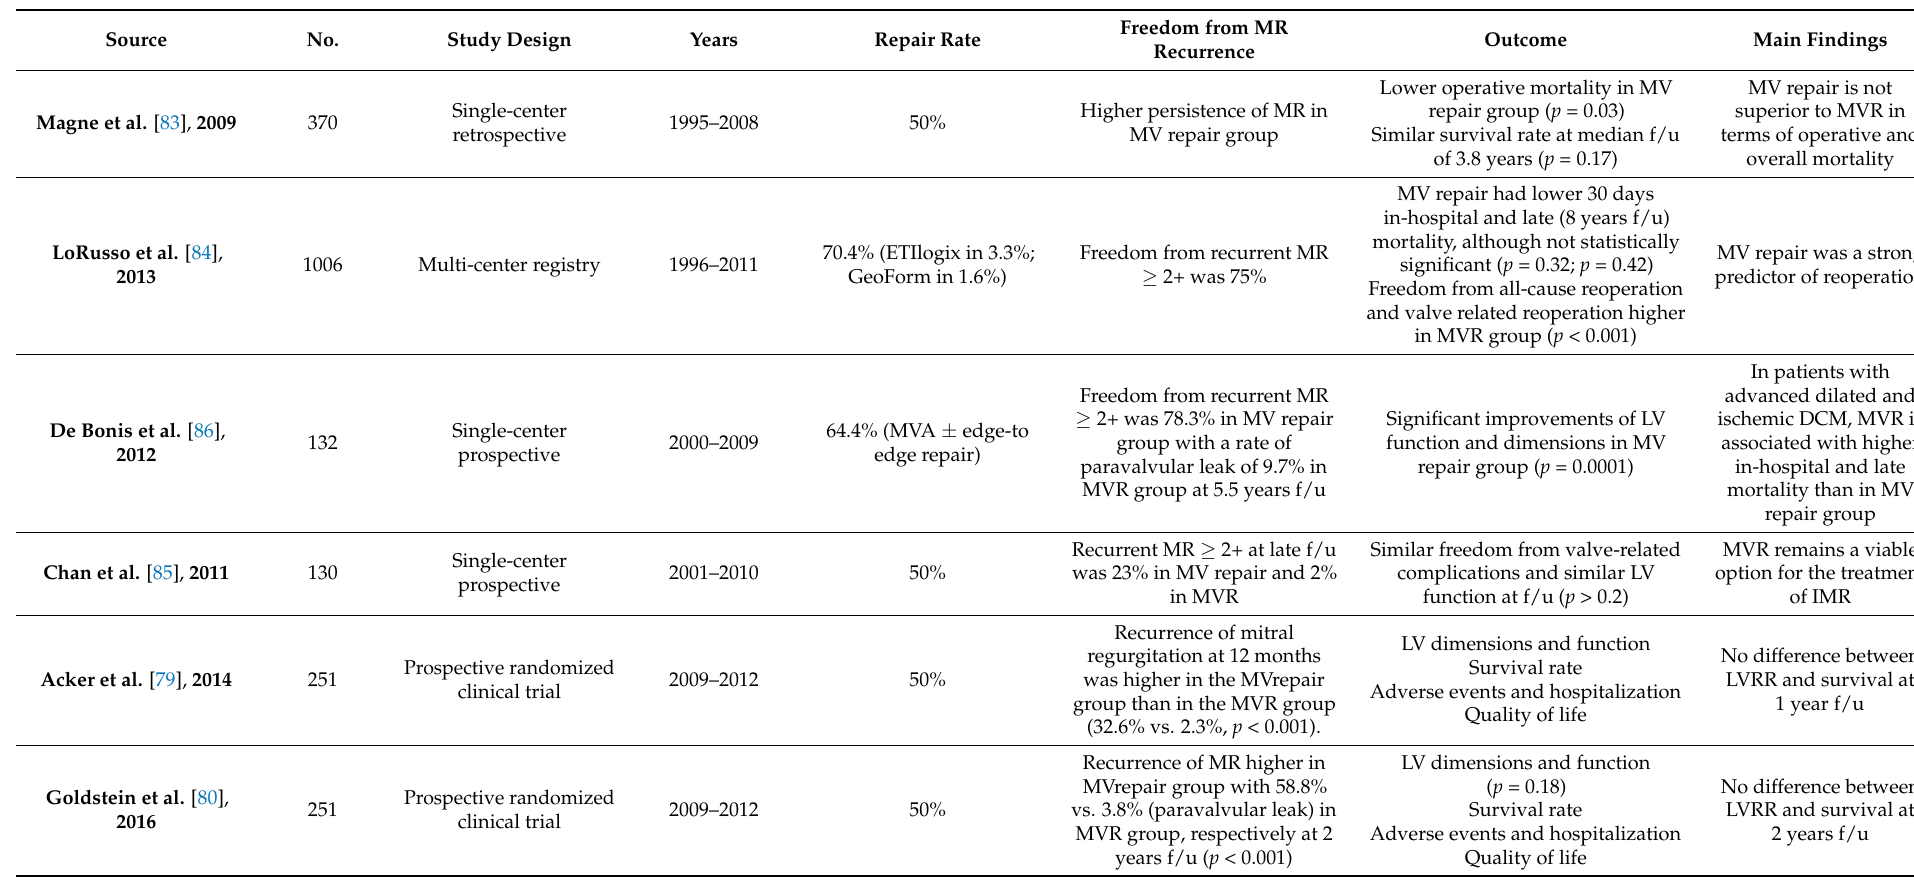
Table 4. Findings from major studies comparing freedom from mitral regurgitation recurrence and clinical outcomes between mitral valve replacement and repair in the management of severe